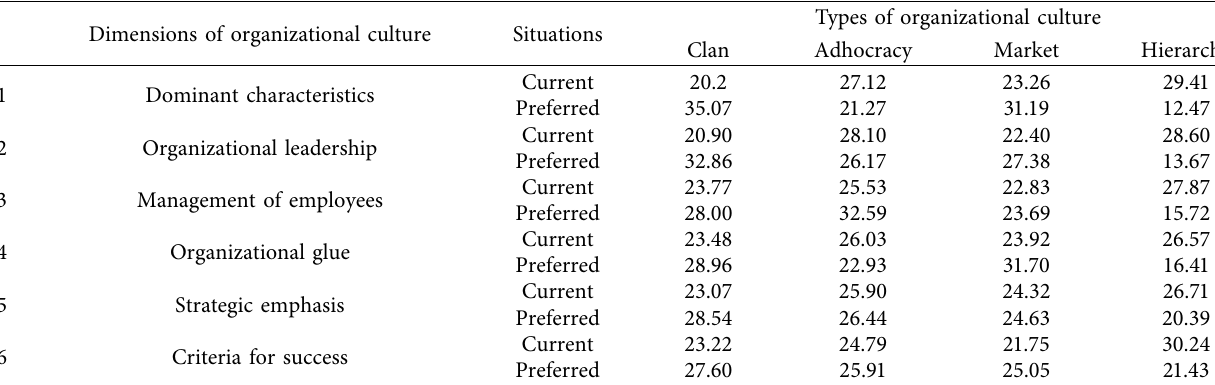
Table 7: Cultural profile and strengths in the current and preferred